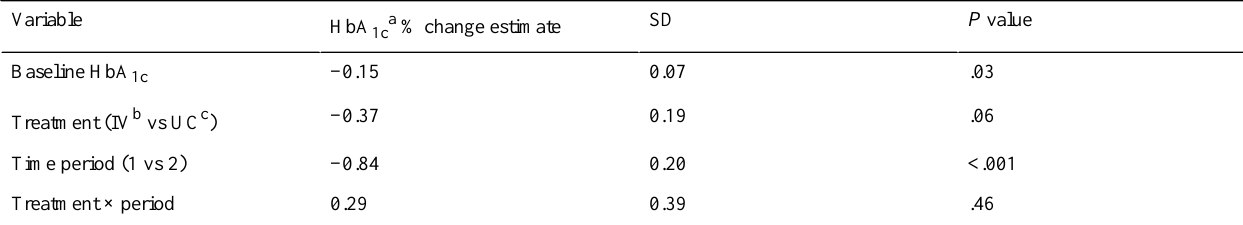
Table 3. Results of crossover (mixed-effects model) analysis of HbA 1c